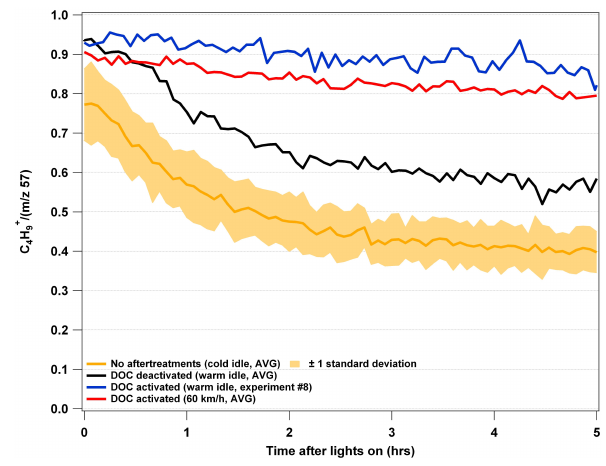
to total m/z 57. 9